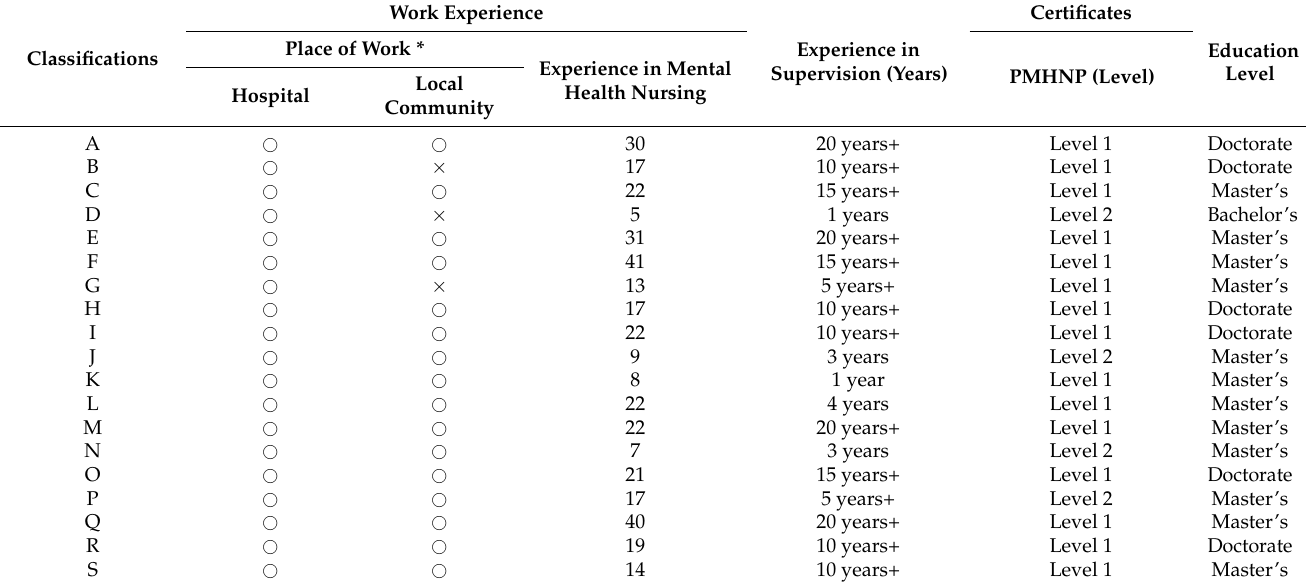
Table 1. General characteristics of the study participants ( N =